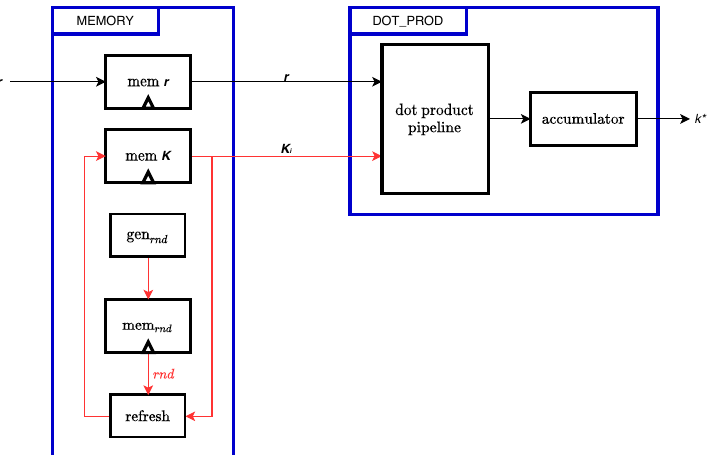
Figure 4: Overview of the crypto-physical dark matter hadrware